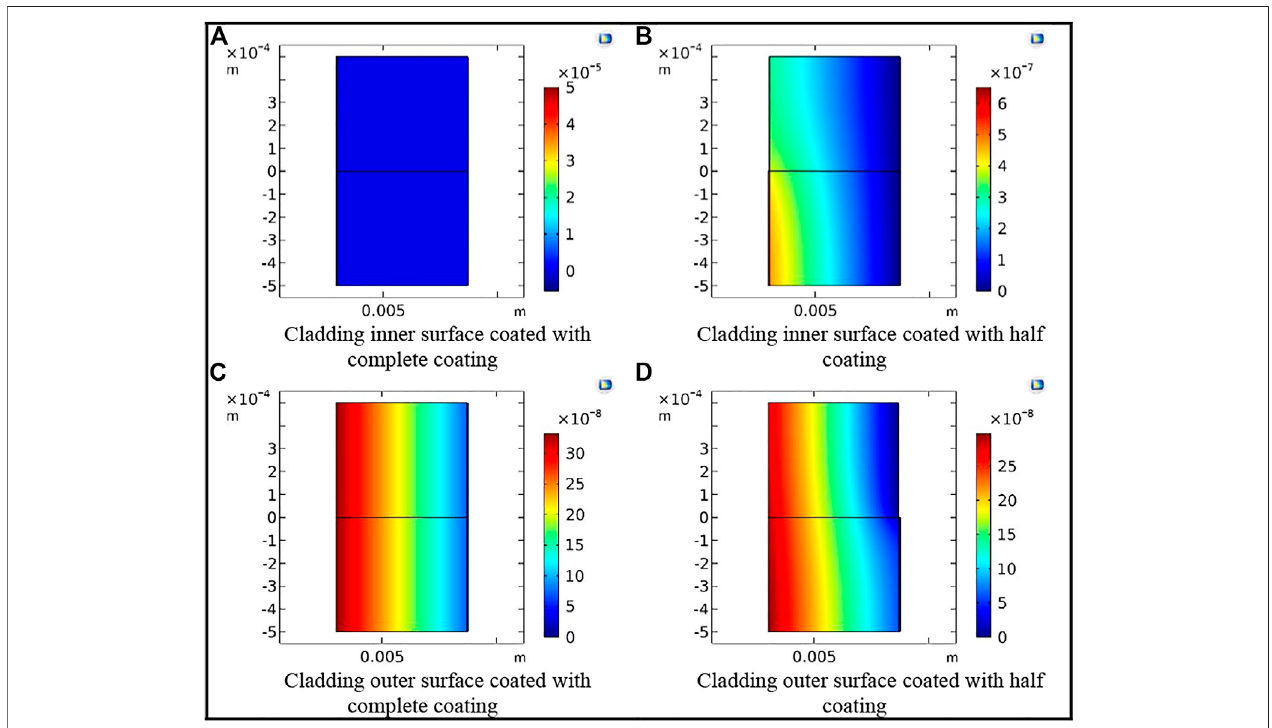
FIGURE 12 | Tritium concentration distribution in the cladding with different coating defects at t = 120,000 s. (A) Cladding inner surface coated with complete coating. (B) Cladding inner surface coated with half coating. (C) Cladding outer surface coated with complete coating. (D) Cladding outer surface coated with half coating.